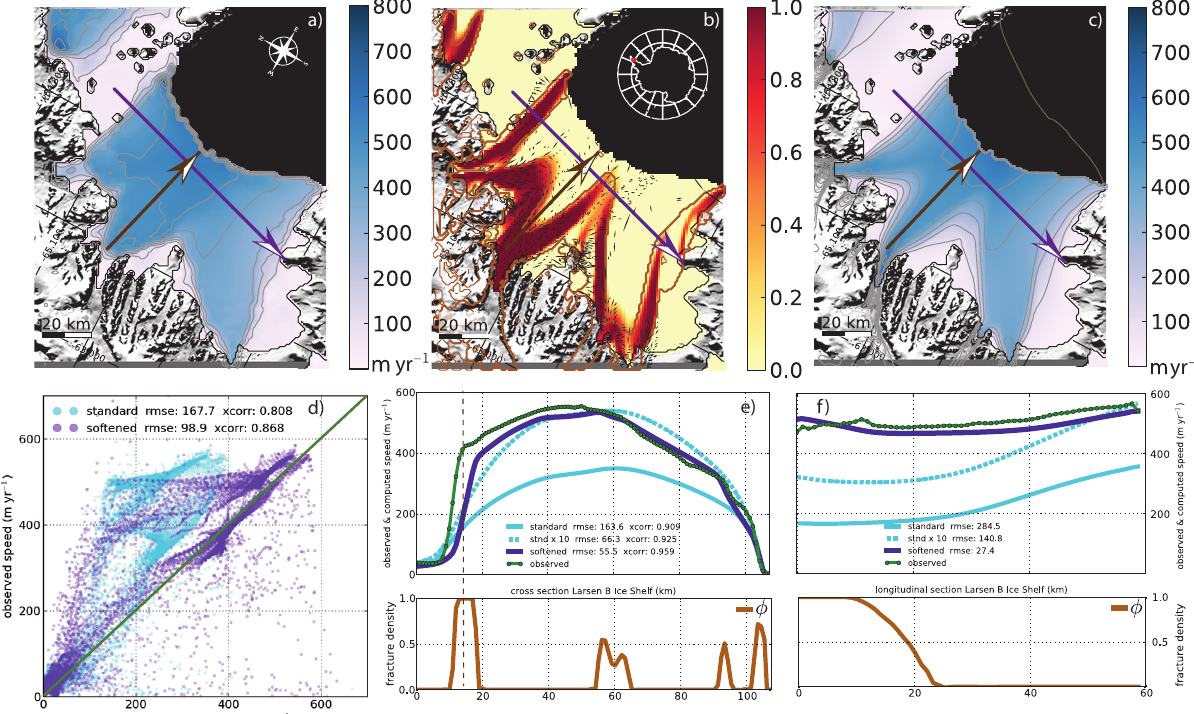
Fig. 12. Observed surface speed of the years 1997 to 2000 as well as calculated fracture density and ice speed in the Larsen B ice shelf (a–c) . Point-by-point correlation of calculated and observed ice velocities in the lower left panel (light blue for constant enhancement factor and violet with fracture softening). (e–f) demonstrate the effect of the coupled fracture density on the calculated ice speed (cf. light blue, dashed and violet) compared to observed speeds (green) along the indicated transverse section (violet arrow) and longitudinal section (brown arrow). Parameters: FESOM-melting factor 0.2, E SSA = 1 . 0, γ = 1 . 0, σ cr = 60kPa, γ h = 2 . 0, ˙ (cid:15) h = 6 × 10 − 10 s − 1